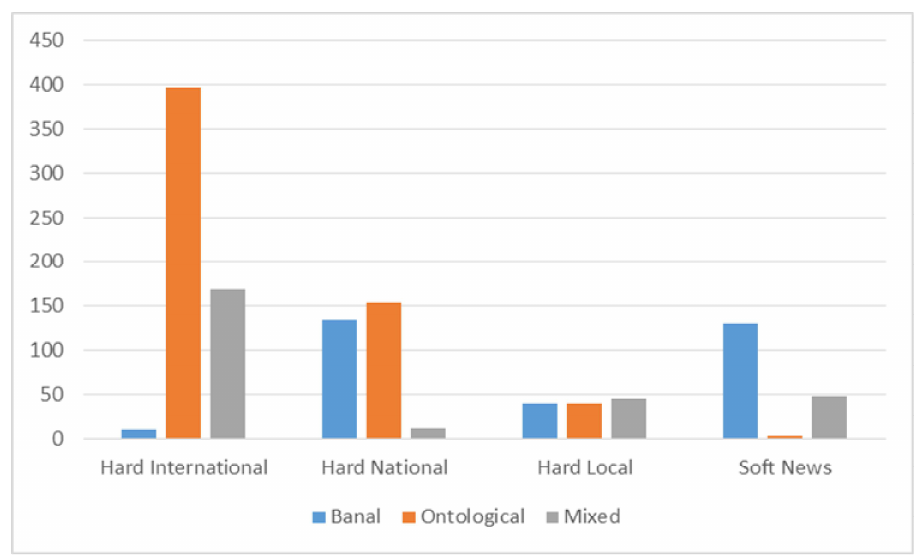
Figure 4. Type of Islamophobic content per section. Source: elaborated by the authors.